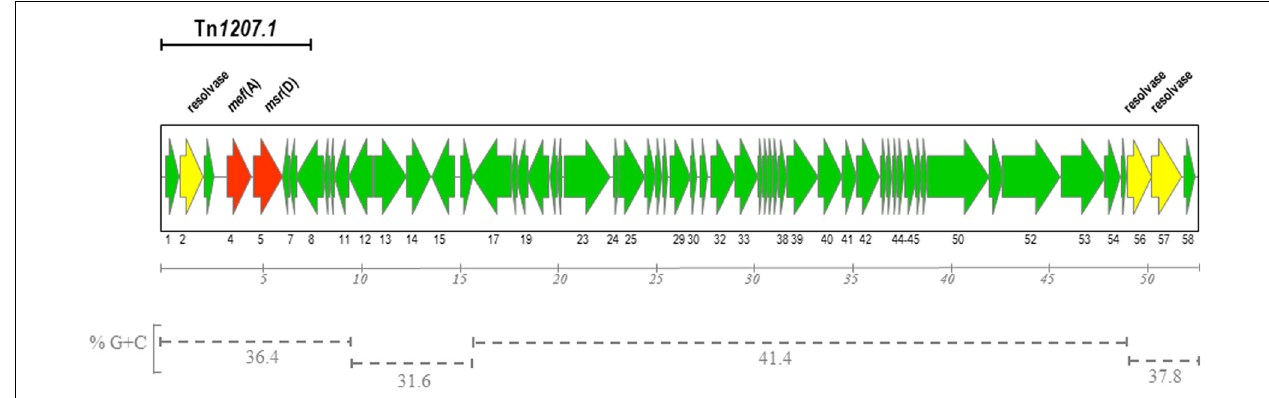
FIGURE 1 | Schematic diagram of Streptococcus pyogenes (cid:2) 1207.3. The element is 52,491 bp in size and contains 58 open reading frames (ORFs). ORFs and their direction of transcription are represented by arrows and the annotated ORFs are indicated only by their numbers. Macrolide resistance